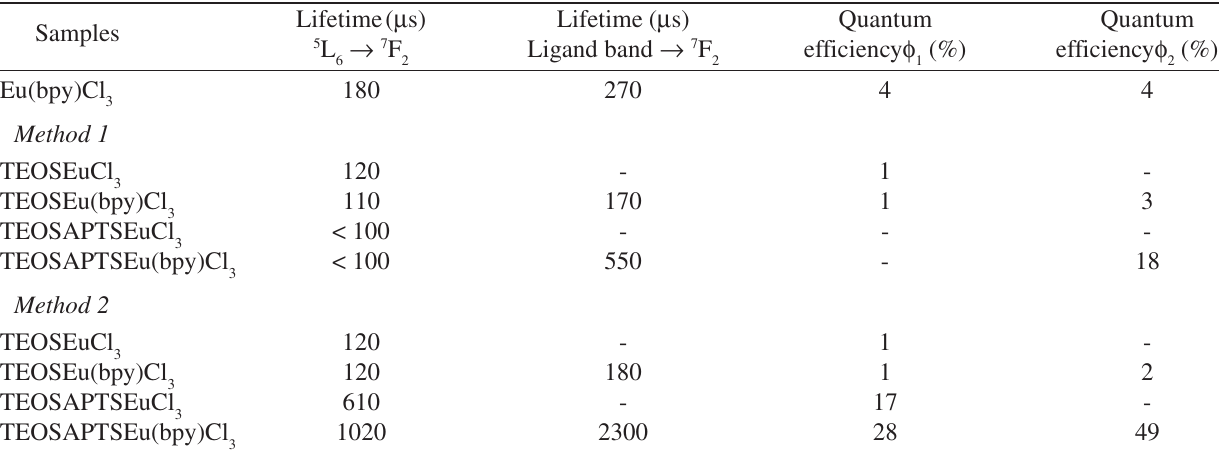
Table 2. Lifetime of the samples and quantum